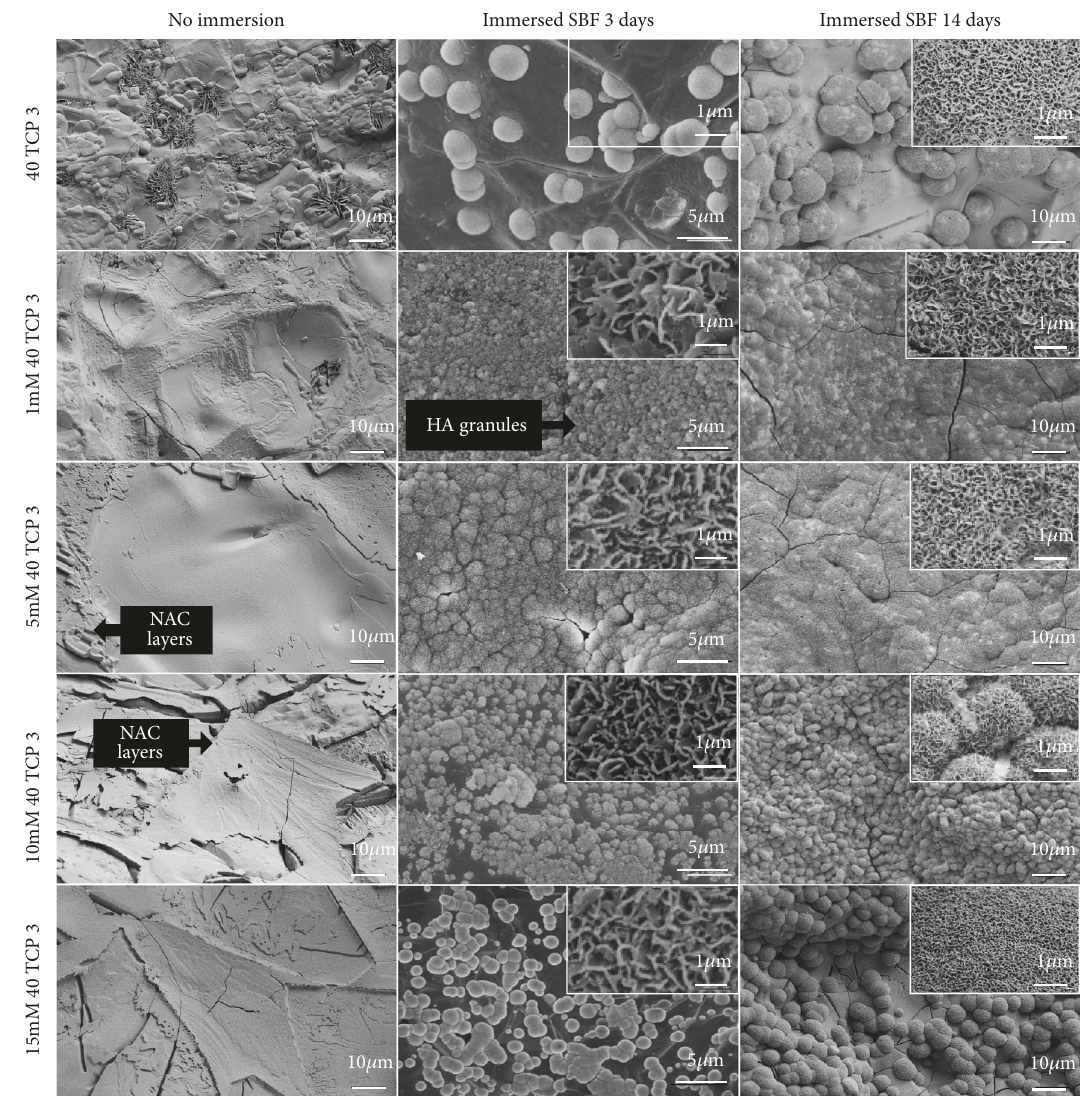
Figure 5: FE-SEM images of the surface of the 𝛽 -TCP and NAC loaded scaffold before and after immersion for 3 days and 14 days in